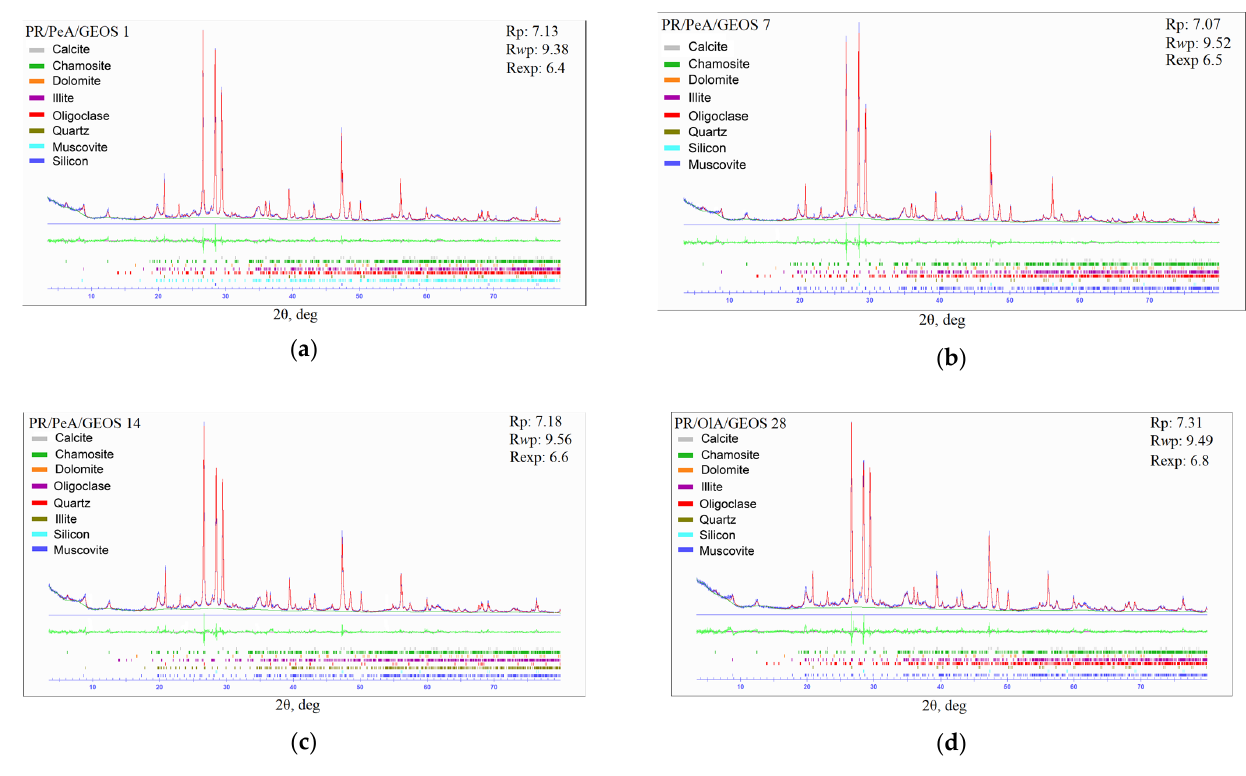
Figure 3. XRPD patterns refined by means of the Rietveld method for PR/PeA/GEOS samples after 1 ( a ), 7 ( b ), 14 ( c ), and 28 ( d ) days of curing with the addition of the external standard (crystalline silicon—Si). Observed and calculated profiles are given in blue and red, respectively. The differences between the observed and calculated powder diffraction profiles are in green. The colored vertical lines below the profile indicate the expected peaks of the phases shown in the legend at the top left and used for refinement.